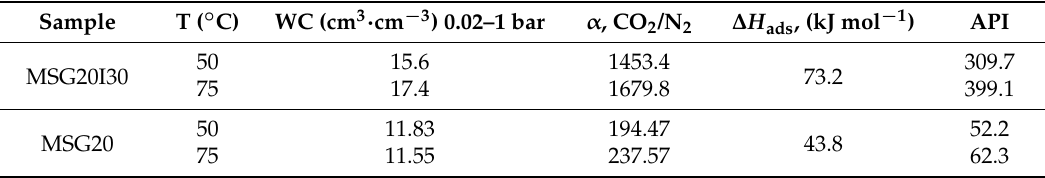
Table 7. Working capacity, CO 2 /N 2 selectivity, adsorption enthalpy, and Adsorbent Performance